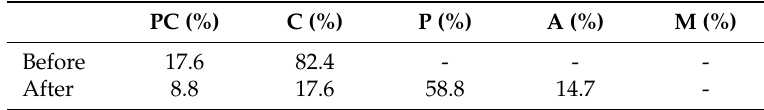
Table 10. Stage of change before and after the trial.